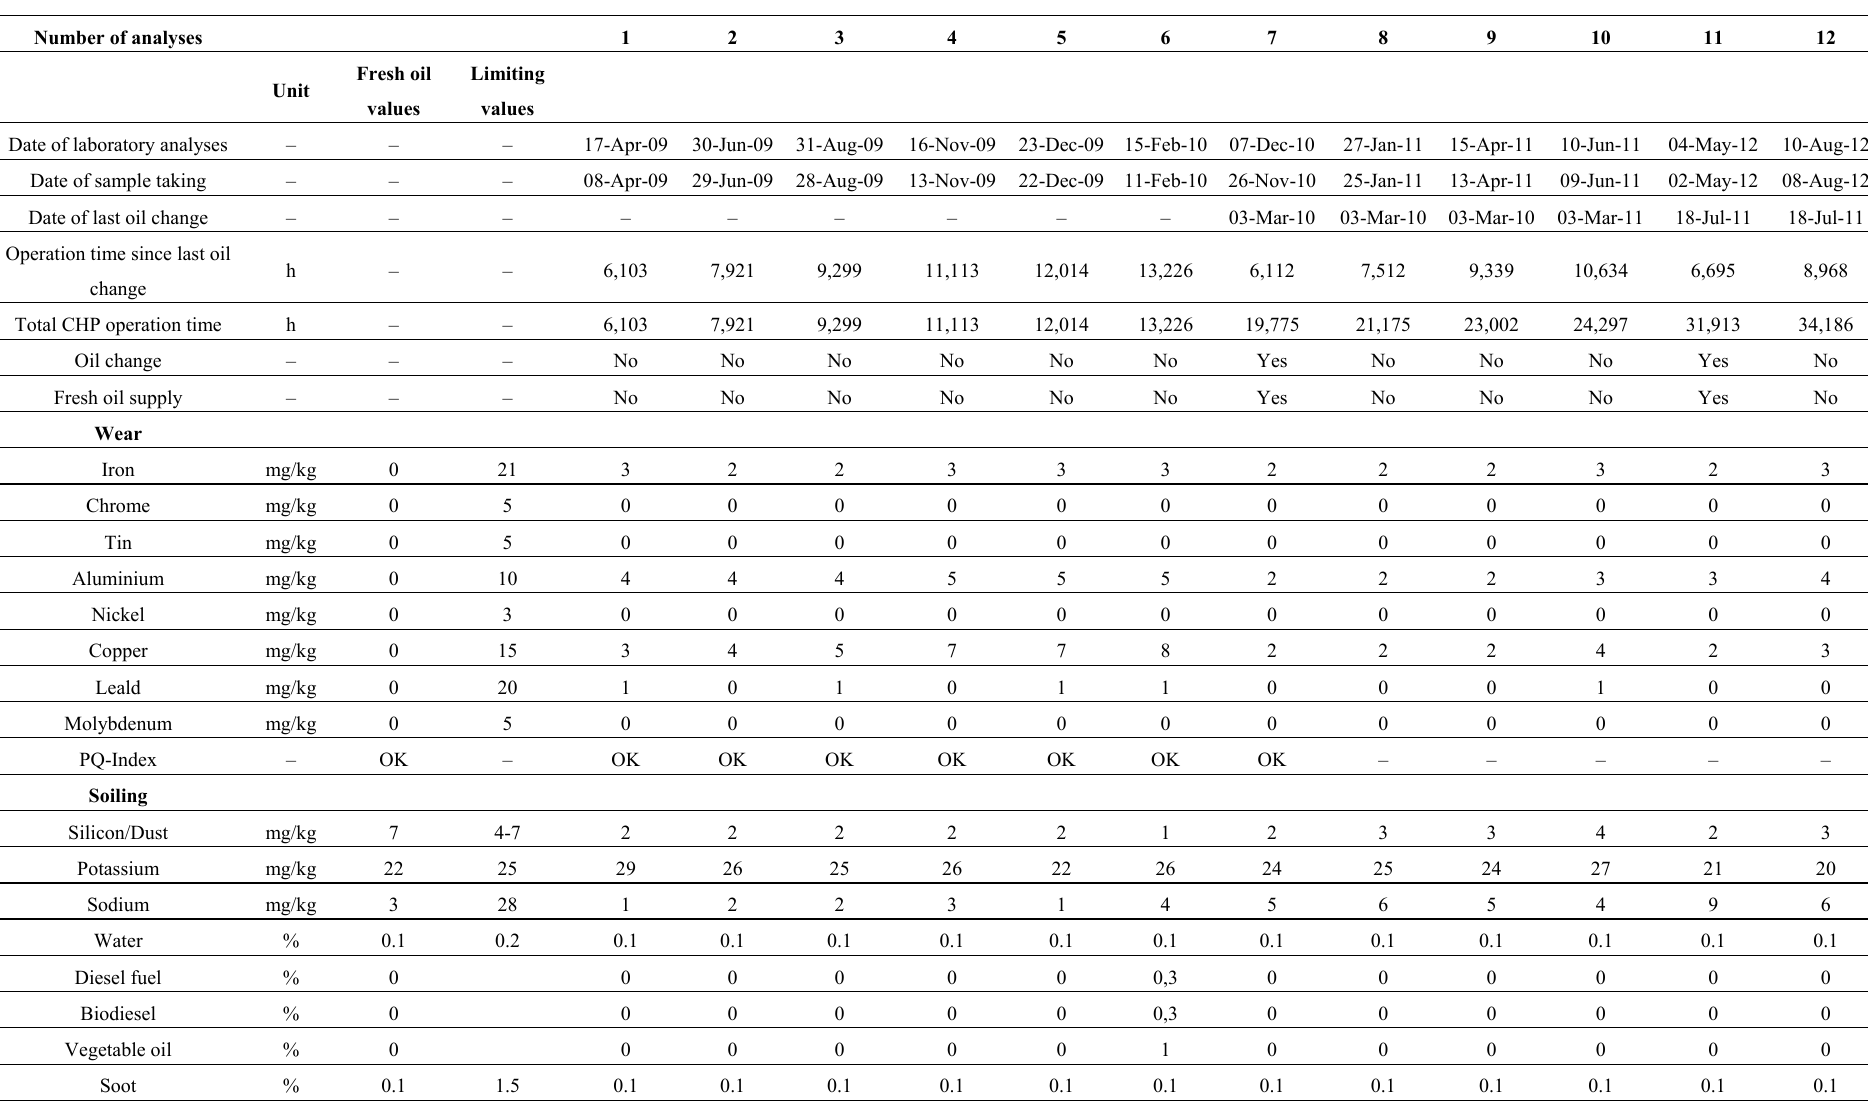
Table 4. Summary of oil inspection